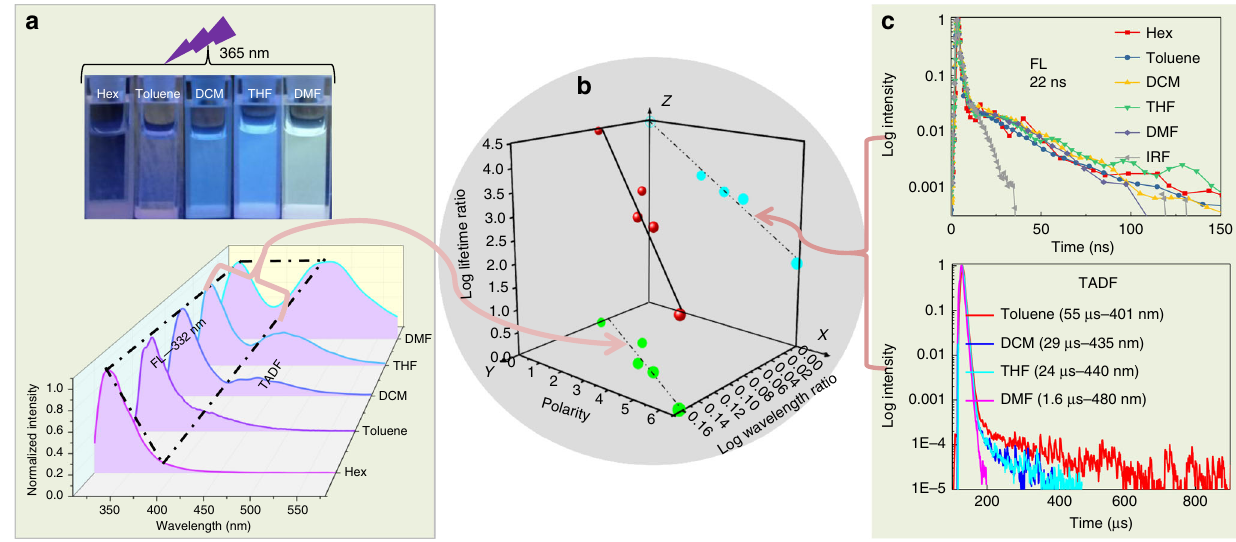
Fig. 4 Correlation of wavelength and lifetime of TADF and FL with polarity. a Emission spectra of 3 in various solvents under ambient condition ( λ ex = 300 nm) and the photographs of 3 under UV light (365 nm). b Linear- fi tting curves of the log value of wavelength and lifetime ratio (TADF to FL) with polarity change separately, as well as the formation of a 3-D plot diagram accordingly. c PL lifetime of FL and TADF bands in different solvents. FL, fl uorescence; PL, photoluminescence; TADF, thermally activated delayed fl